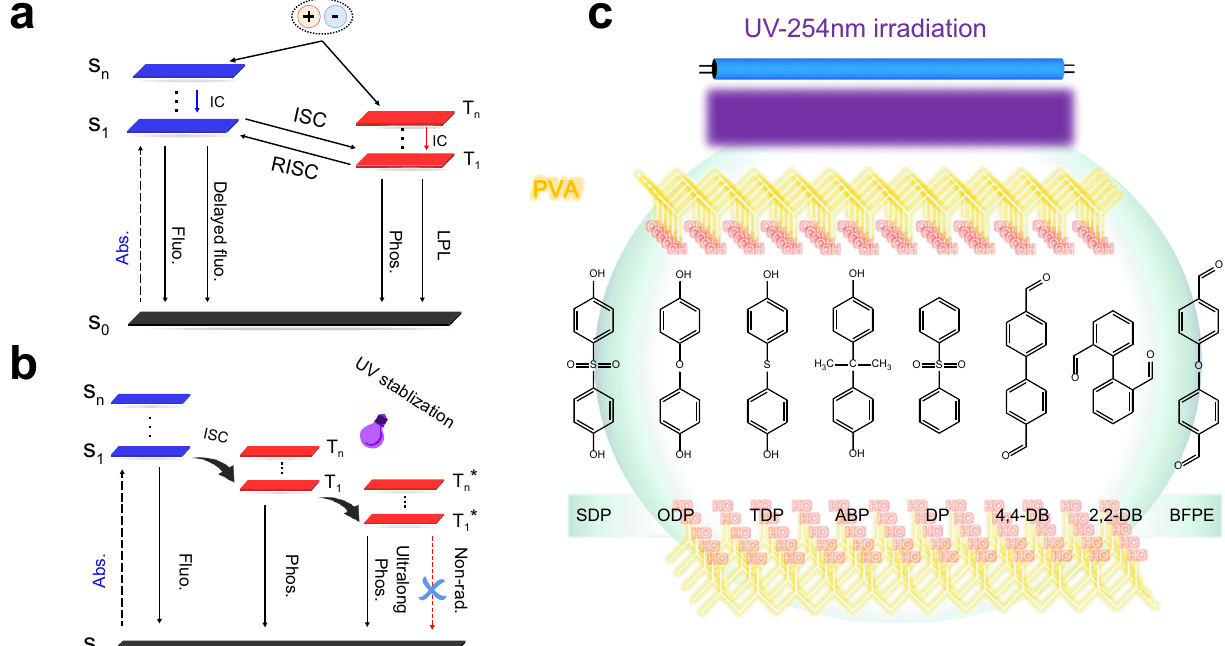
Fig. 1 Schematic representation for the manipulation of an UV irradiation-responsive organic molecule-doped PVA system. a Schematic illustration the competitive decay channels of luminescent materials. b Proposed mechanism and c molecular structures for irradiation-responsive ultralong RTP systems. Singlet excitons (S n ) produce triplet excitons (T n ) through the ISC process, and suppressing nonradiative transitions of the molecules leads to ef fi cient phosphorescence. The formation of a rigid surrounding matrix can stabilize the triplet excitons and generate radiation-dependent phosphorescence. Abs. absorbance, Fluo. fl uorescence, Phos. phosphorescence, LPL long persistent luminescence, IC internal conversion, Non-rad.